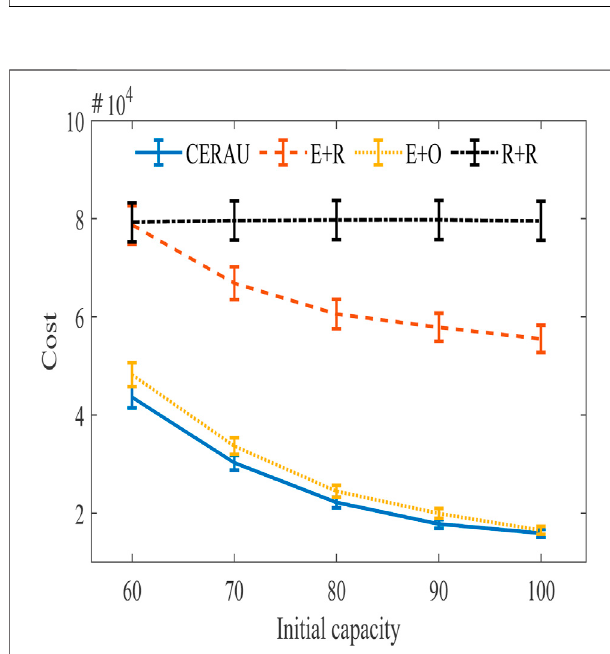
FIGURE 12 | Experimental results based on Google dataset with public